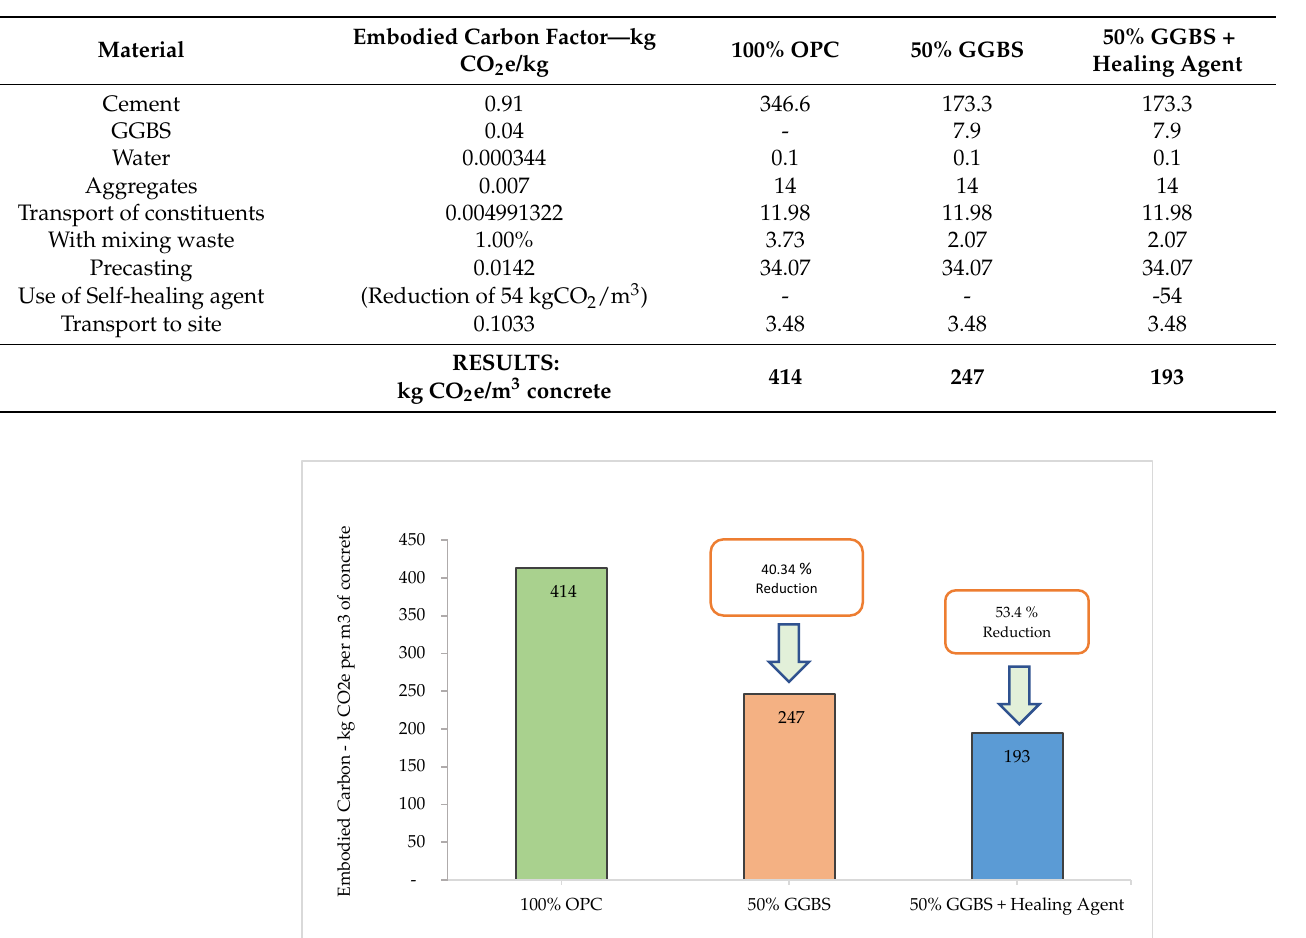
Table 16. Embodied carbon comparison adapted from ICE (Inventory of Carbon and Energy) [1].